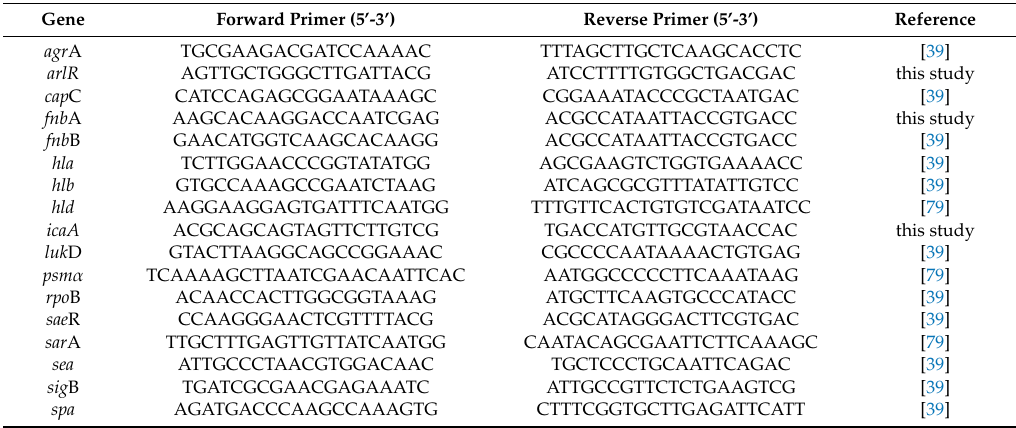
Table 3. Gene target list and oligonucleotide sequences.